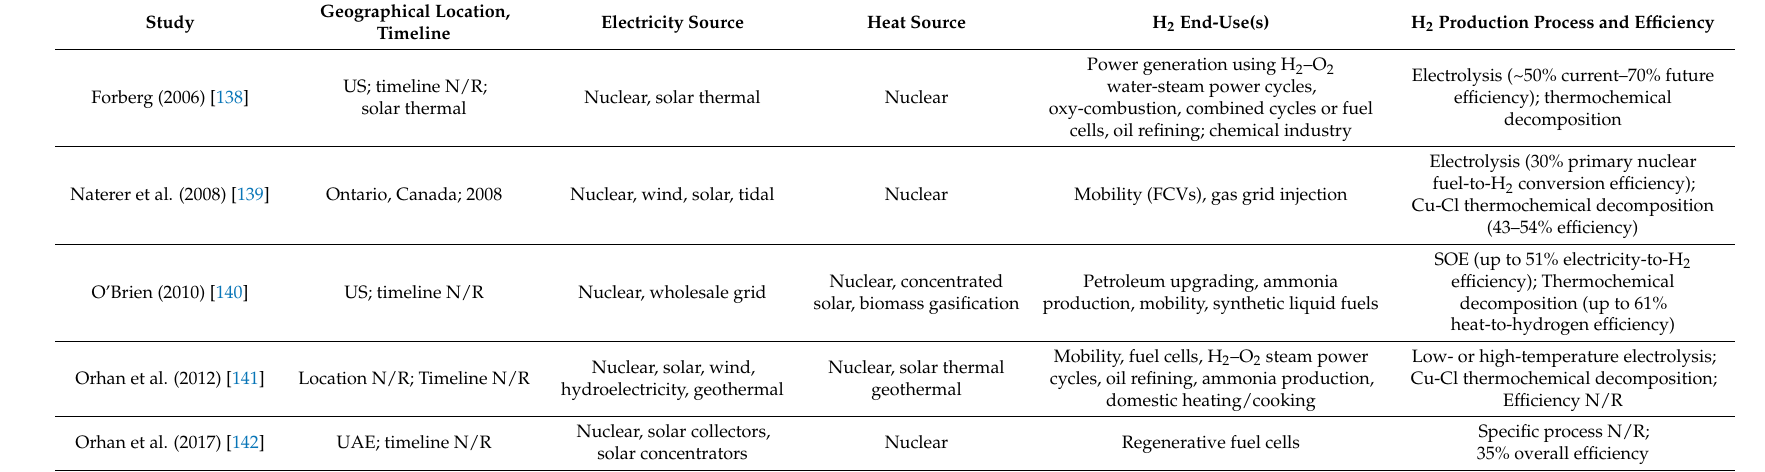
Table 3. Summary of nuclear-assisted power-to-hydrogen deployment